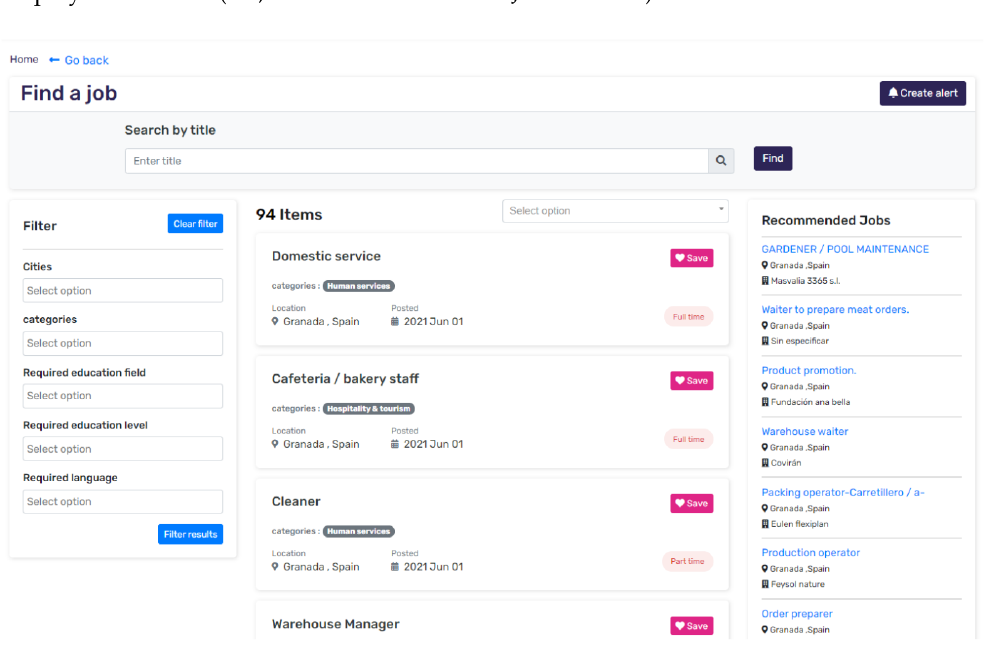
Figure 16. Job recommendations in the